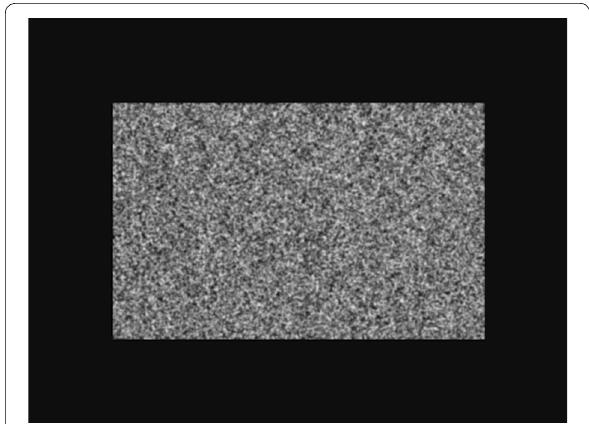
Fig. 1 An example of visual noise image that was classified as ‘face’ by the six out of seven